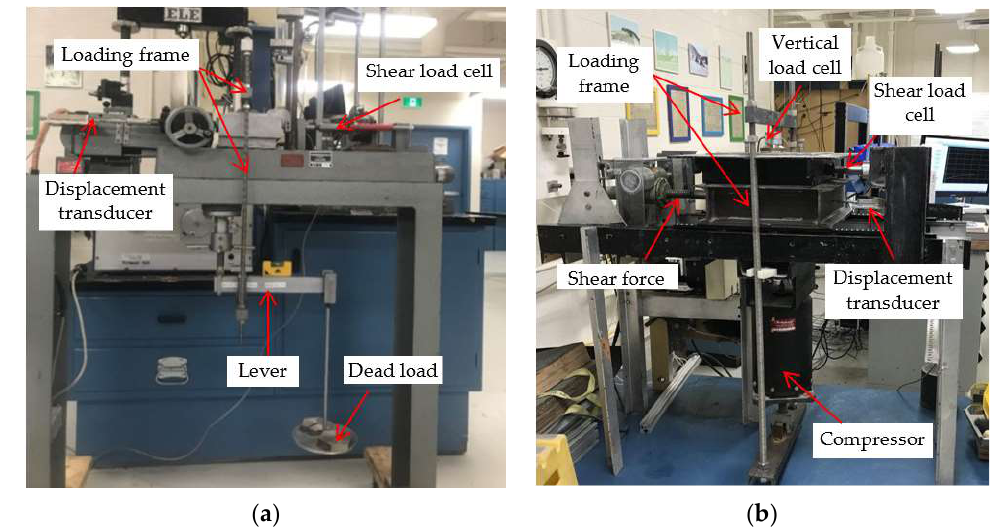
Figure 1. Direct shear apparatuses: ( a ) standard one for mini and small shear boxes; ( b ) large one for large shear box.